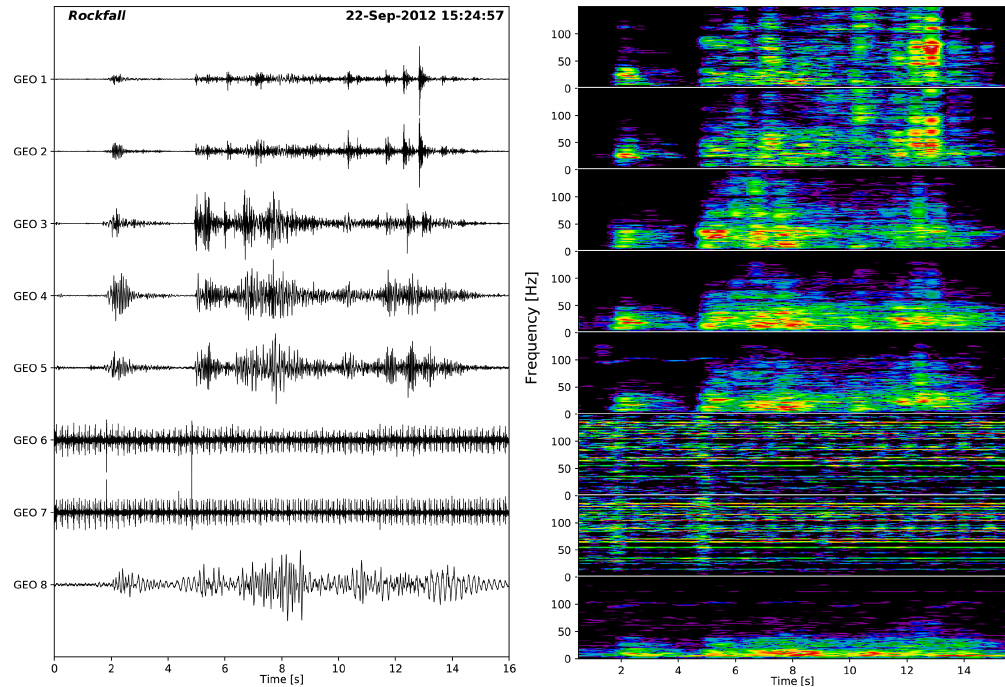
Figure B5. Example of a rockfall. Note the distinctive variability of the waveforms across the geophones. Geophones 6 and 7 were not functional.